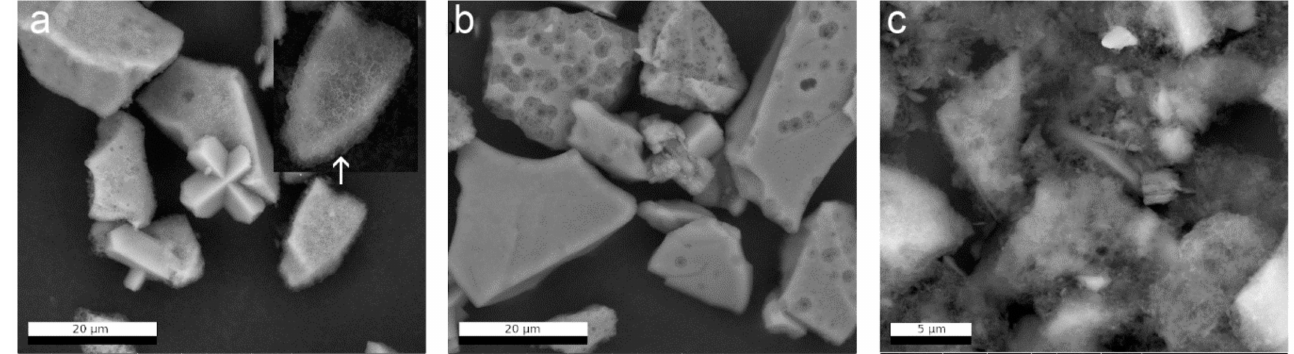
Figure 6. SEM-BSE image of ( a ) the complete altered glass powder after 385 days in YCWCa at 70 ◦ C, i.e., before grain size fractionation, ( b ) the grain size fraction >5 µ m, ( c ) the grain size fraction <5 µ